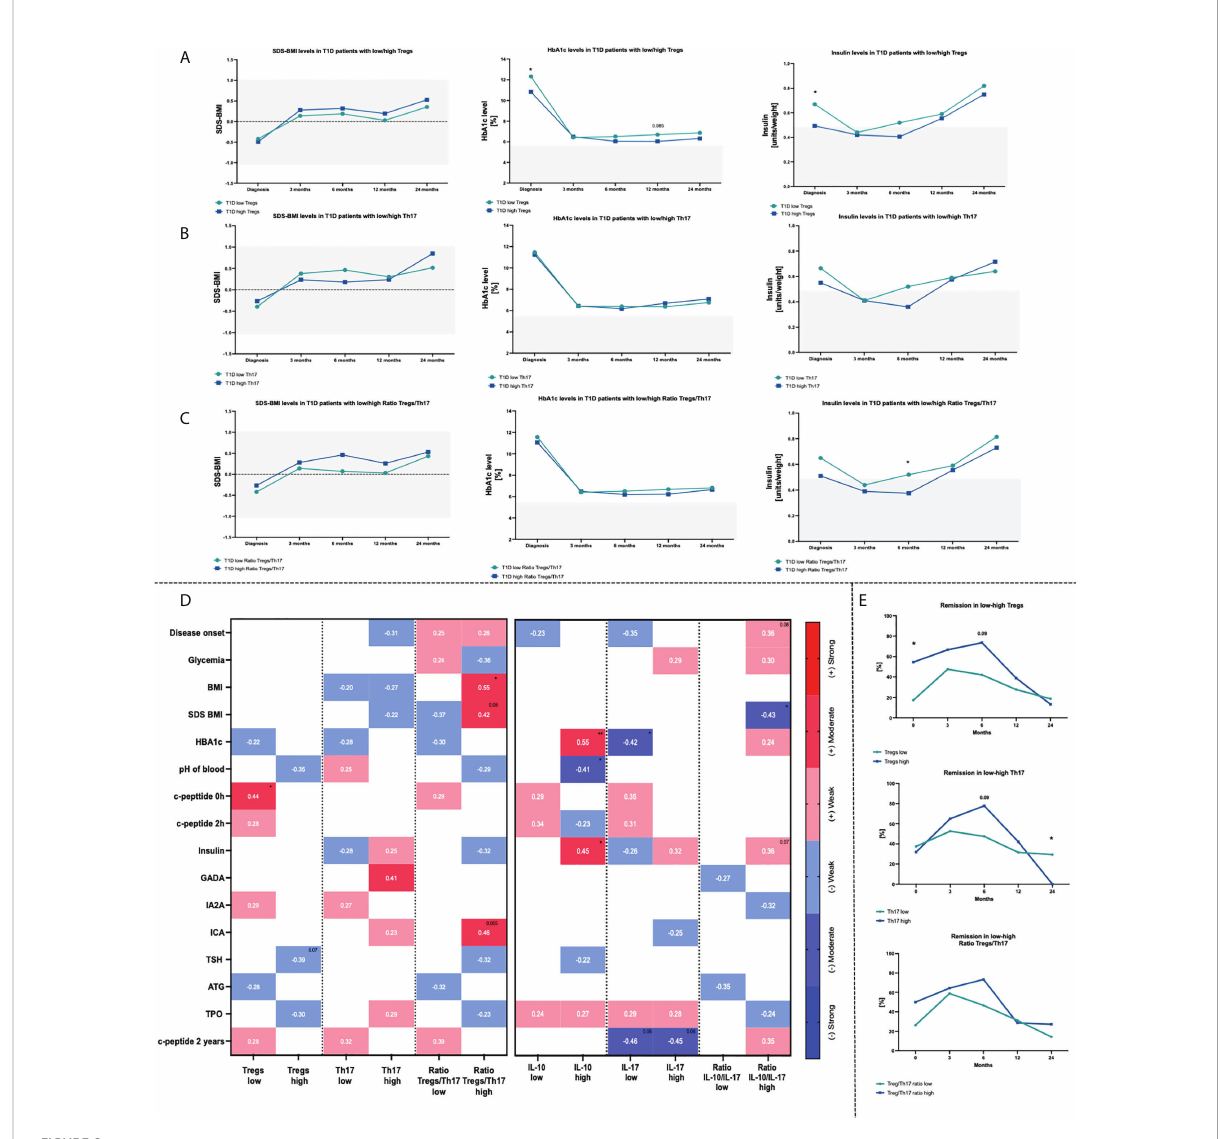
FIGURE 2 In fl uence of Treg and Th17 cells level on changes within HbA1c, SDS-BMI and Insulin dosage. Time-related variations in selected parameters in context of Treg (A) , Th17 (B) cells and Treg/Th17 ratio (C) . Correlations between Treg/Th17 cells or related plasma cytokines (IL-10/IL-17A) and diagnostic data (D) . Frequency of T1D children in remission state depending on the initial Treg or Th17 cells numbers (E) . Heat-maps demonstrate r values with exact values and color indicating strength subgroup. The levels of signi fi cant differences were indicated with asterisks or exact p values: * - p < 0.05; ** - p <